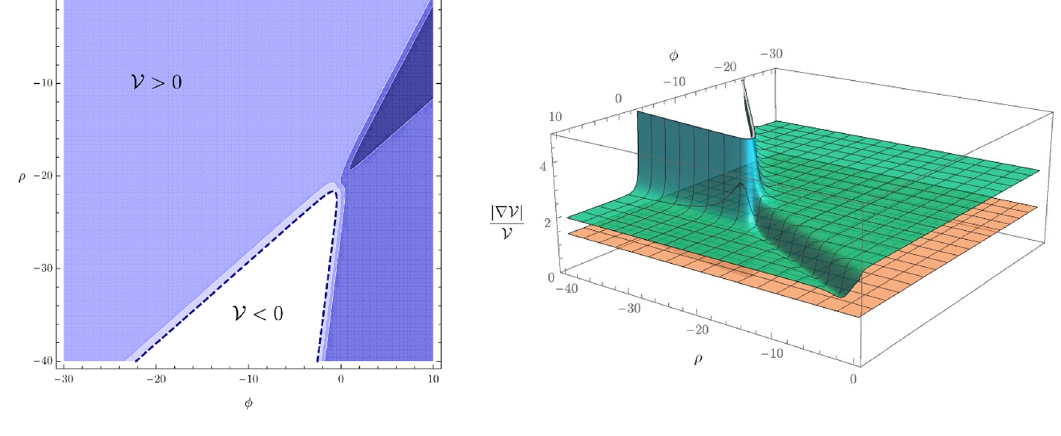
Figure 4 . On the left, in blue, the four regions of (cid:12)eld space where 1 : 5 (cid:20) jrVj 2 : 5 (cid:20) jrVj < 3 : 5 and jrVj (cid:21) 3 : 5 are depicted for the BSB model and the type 0 0 B model, described V V by the parameters in eq. (2.18). Lighter colors correspond to greater values of jrVj a plot of jrVj V